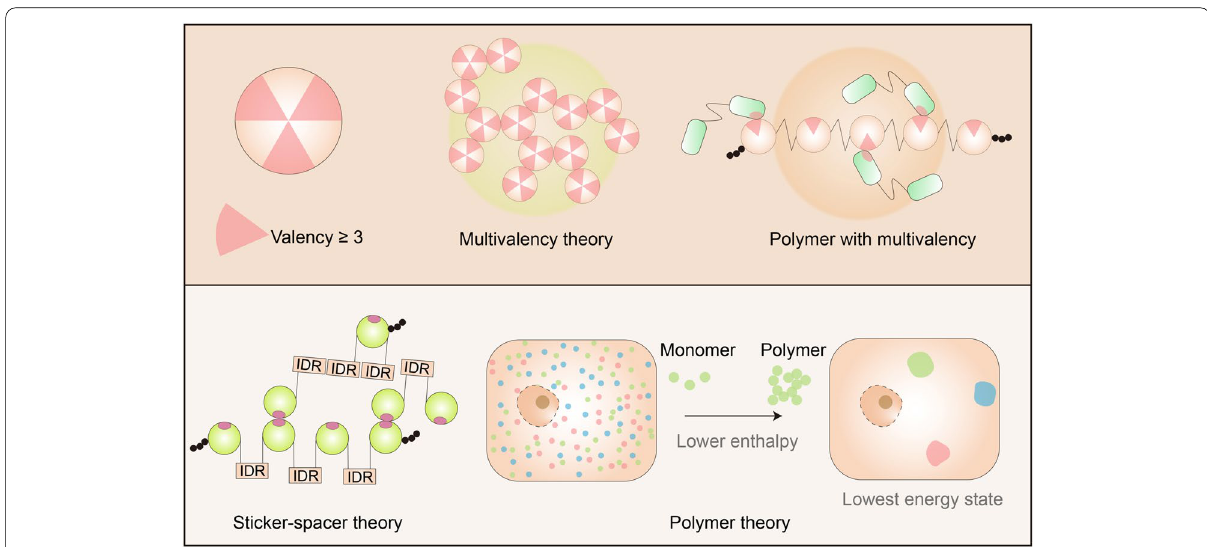
Fig. 2 Theories on phase separation. Three different theories were proposed to explain LLPS. Multivalency theory indicates protein(s) or a peptide or a part of nucleotides has more than three valences to bind with other molecules, which can interact with others in more than two dimensions. Polymers and long-chain structures are ideal for the multivalency theory. Sticker-spacer theory is similar to the multivalency theory, except it focuses more on the ordered and interaction regions. Polymer theory is based on the hypothesis that the attraction between LLPS proteins is much stronger than its attraction with its surrounding environment. Therefore, the LLPS system can reach the lowest energy state because of the low enthalpy caused by